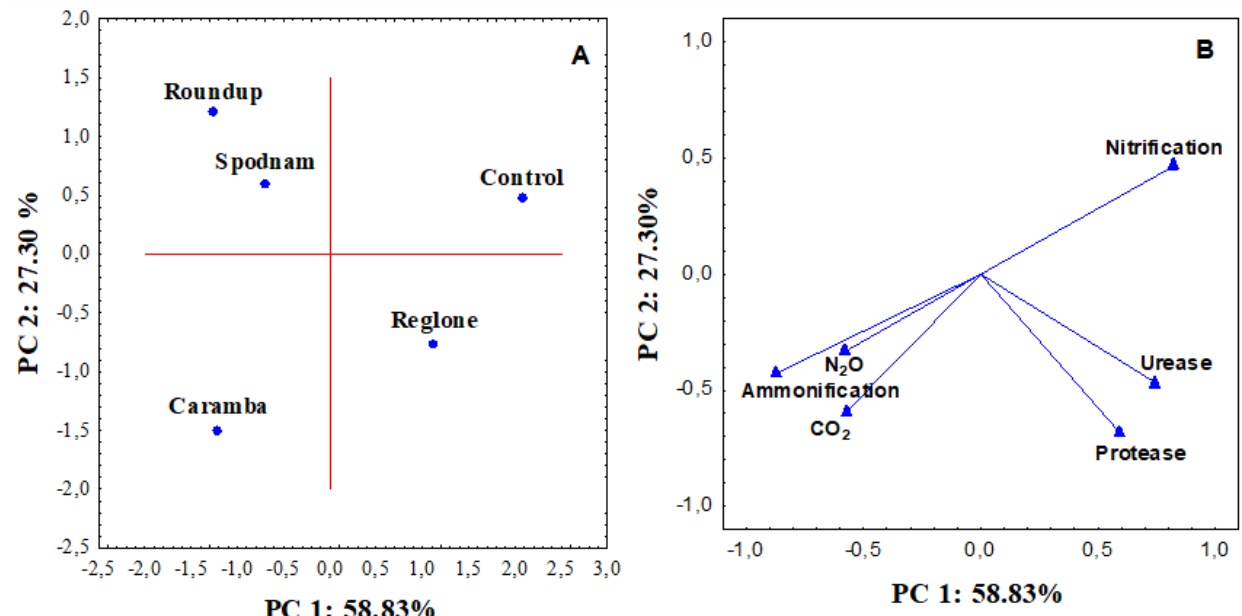
Figure 4. PCA score plot ( A ) and loading plot ( B ) showing the results of the analyzed soil parameters.